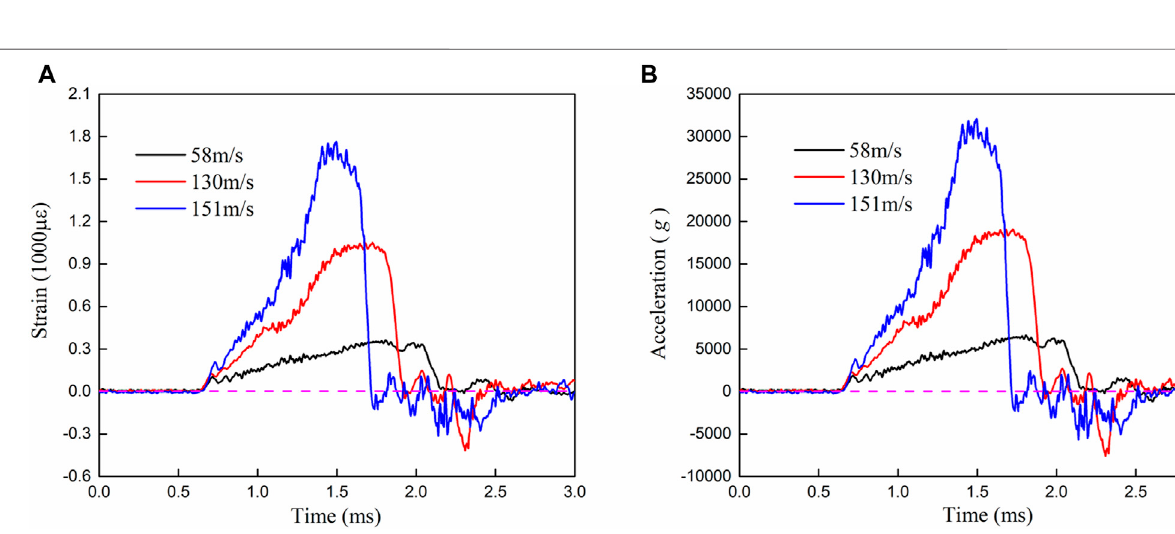
FIGURE 10 | (A) Strain test curves and (B) the acceleration curves of the projectile at various impact